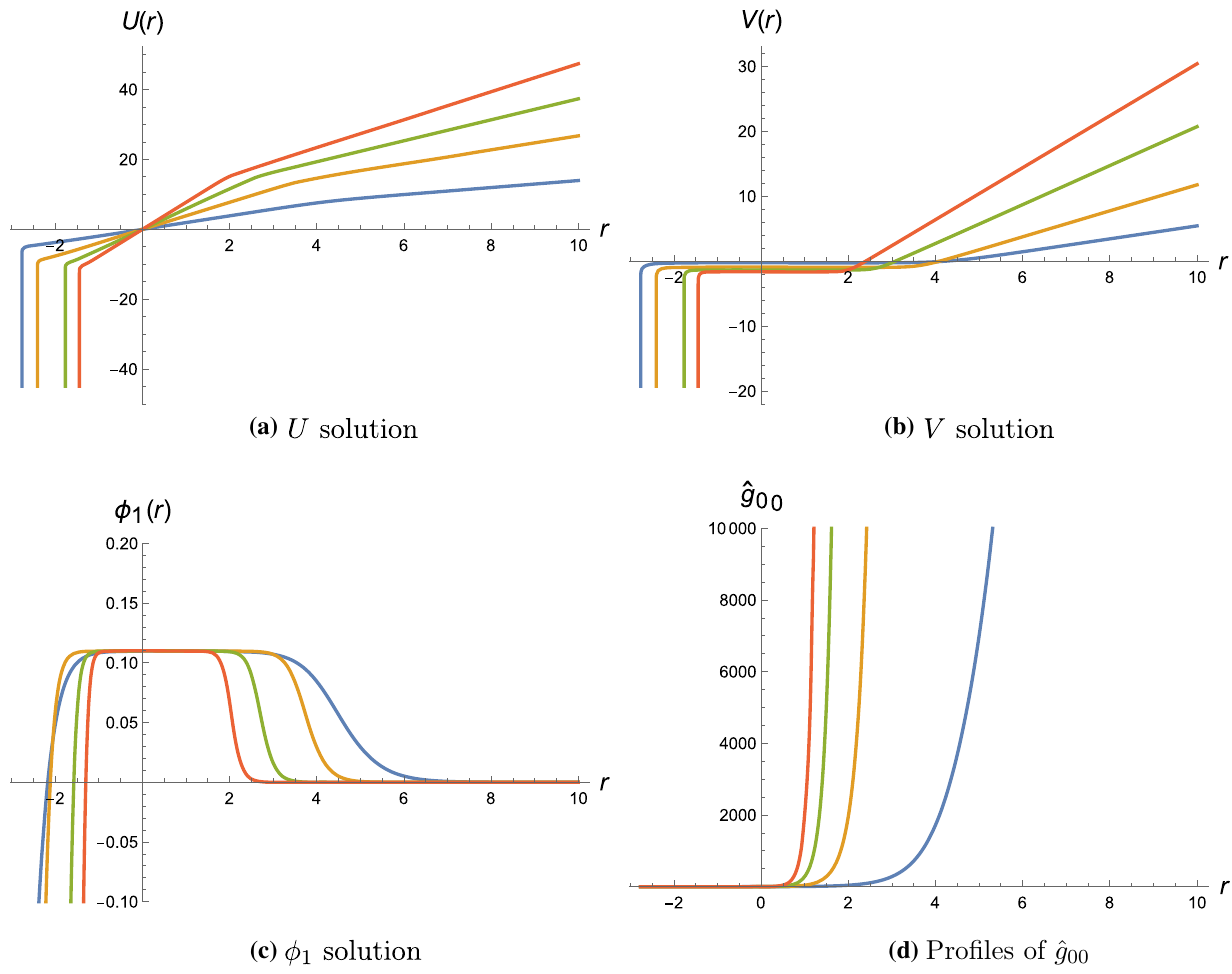
Fig. 22 RG flows from the N = 4 AdS 7 critical point to the AdS 3 × CH 2 fixed point and curved domain walls with φ 1 → −∞ and φ 2 = φ 3 = 0 for SO ( 3 ) ∼ SU ( 2 ) twist in SO ( 5 ) gauge group. The blue, orange, green and red curves refer to g = 8 , 16 , 24 , 32, respectively